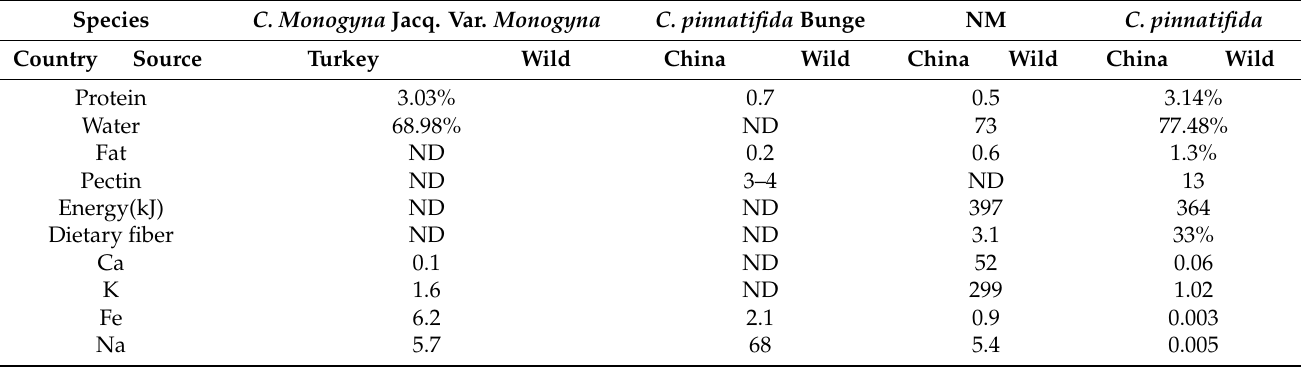
Table 1. Nutritional composition of hawthorn in different regions. Values are expressed as a percent- age (%) and as g per 100 g fresh